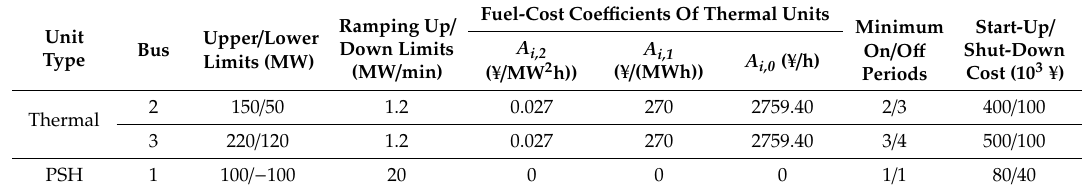
Table 2. Parameters of the generation units.